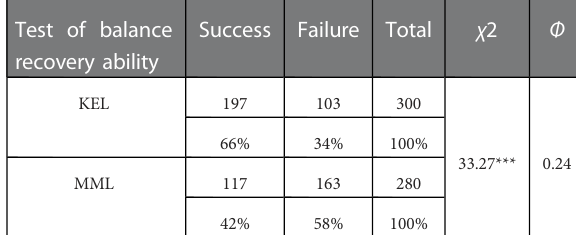
TABLE 4 The difference in success rates in the test of balance recovery